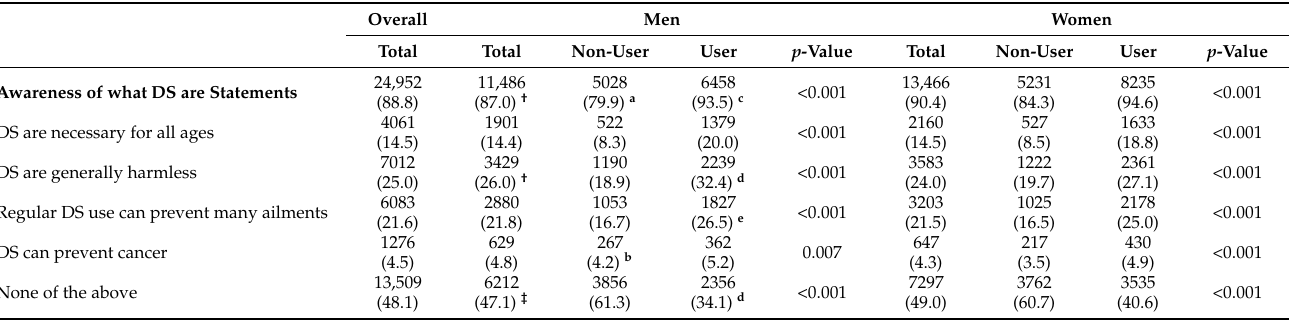
Table 3. Absolute and relative frequencies in parenthesis (%) of the awareness of what DS are and views about DS use according to sex and DS use. The p -values of chi-square tests are presented.